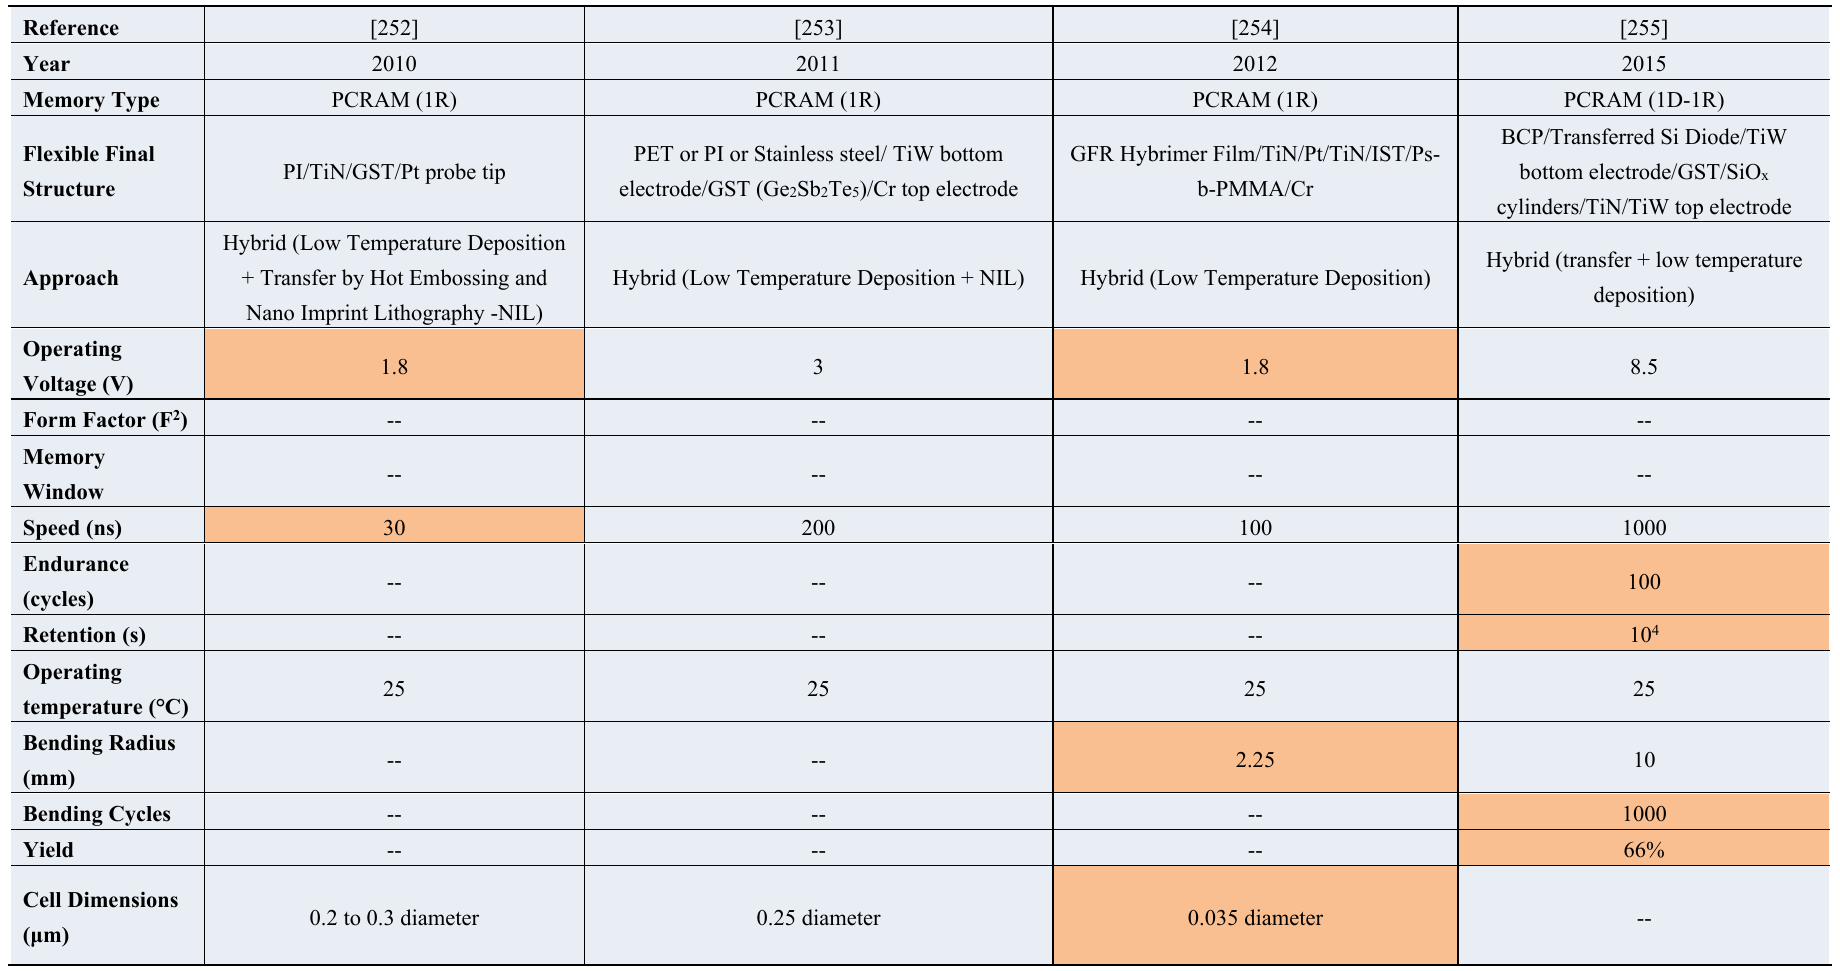
Table 8. Summary of the key works on flexible PCRAM over the past five